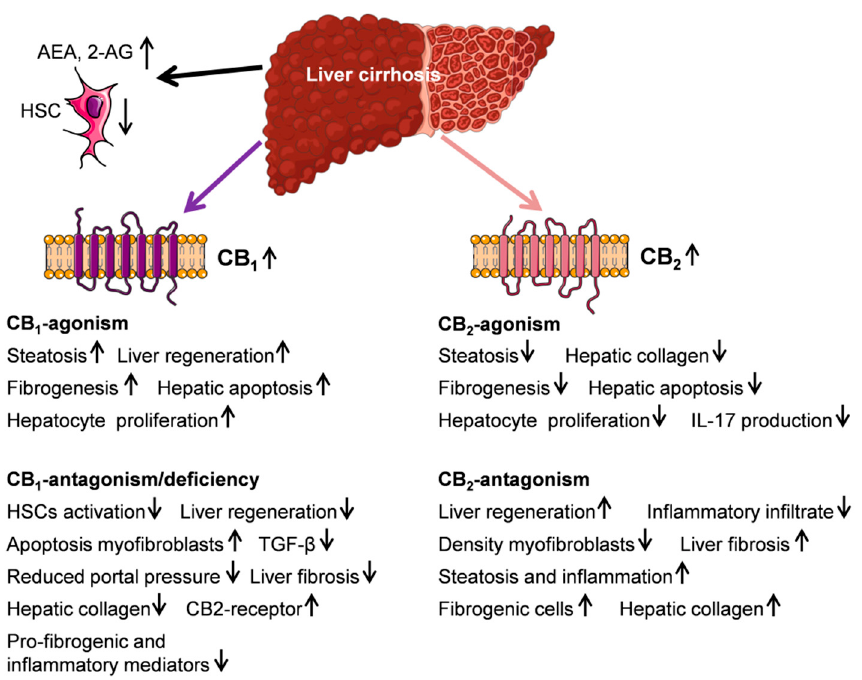
Figure 4. Schematic illustration of cannabinoid receptor (CBR) function in the metabolism of liver cirrhosis. ( ↑ ) and ( ↓ ) define up or down regulation. Most findings were generated in rodent models. This figure was prepared using a template on the Servier Medical Art website (Available at: http://smart.servier.com/).